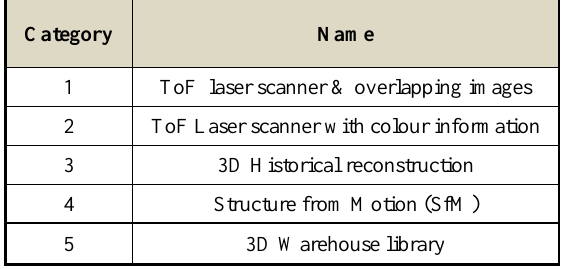
Table 1: Categorization of the 3D models